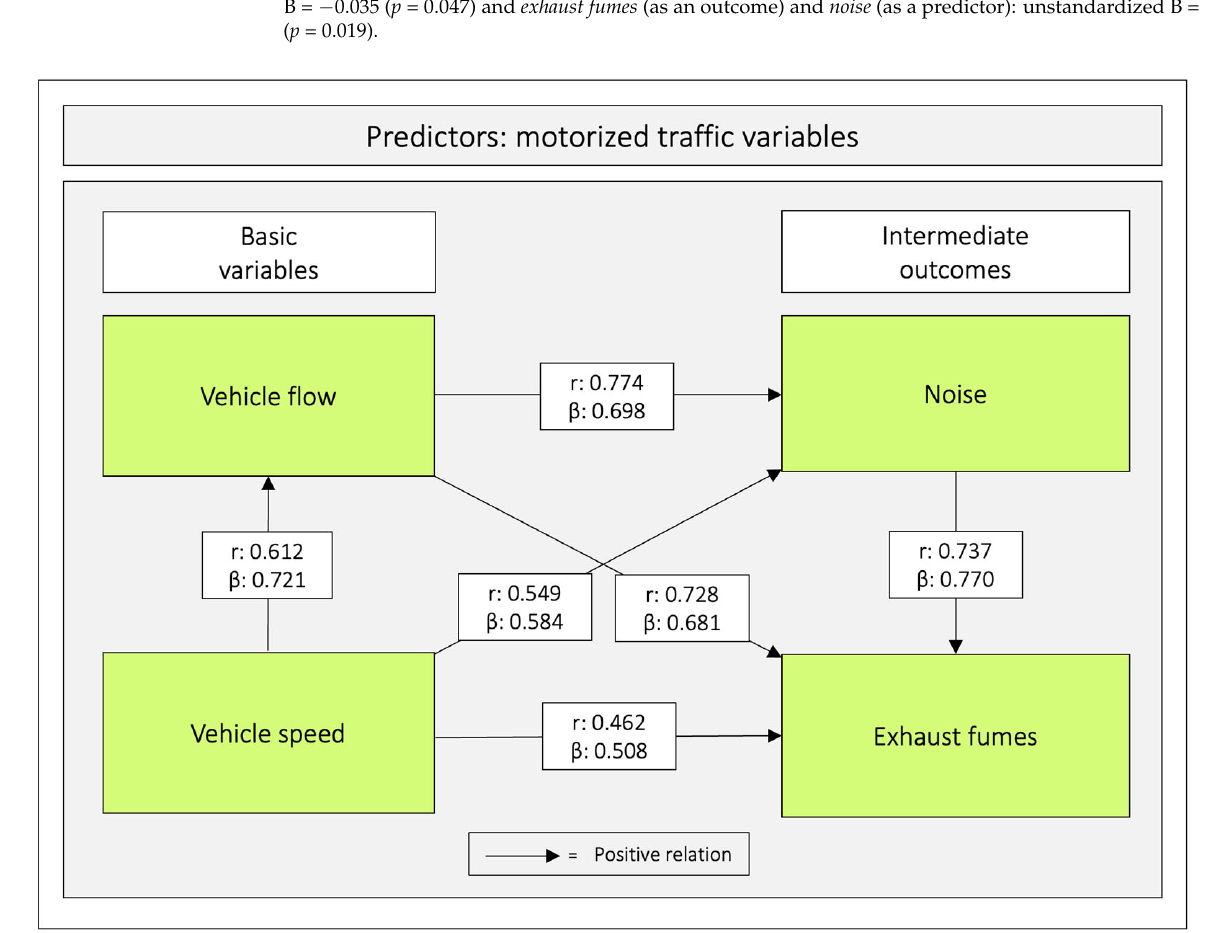
Figure 5. Correlation and regression coefficients between the four predictor variables. Notes: r = Pearson’s correlation coefficient and β = unstandardized beta. The figure is based on Table 4 and Table 5.